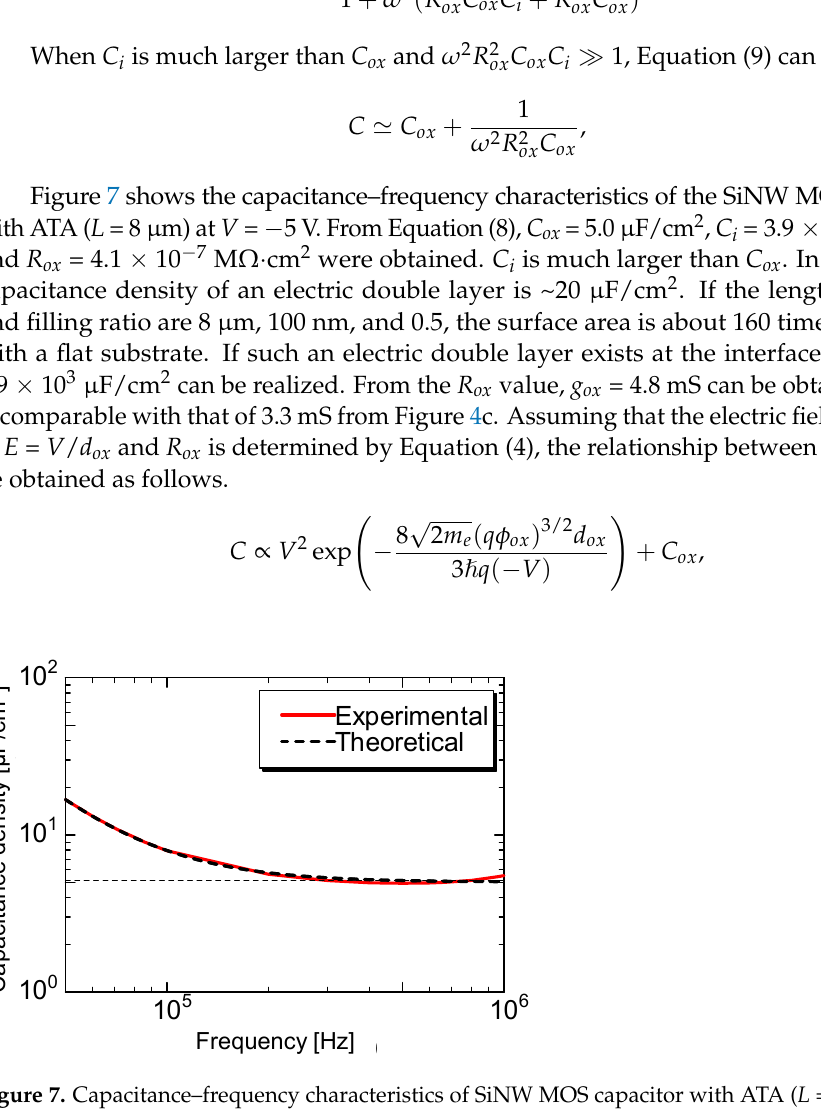
Figure 7. Capacitance–frequency characteristics of SiNW MOS capacitor with ATA ( L = 8 µ m) at V = − 5 V. The solid line shows an experimental curve, and the dashed line shows theoretical capacitance density represented by the Equation